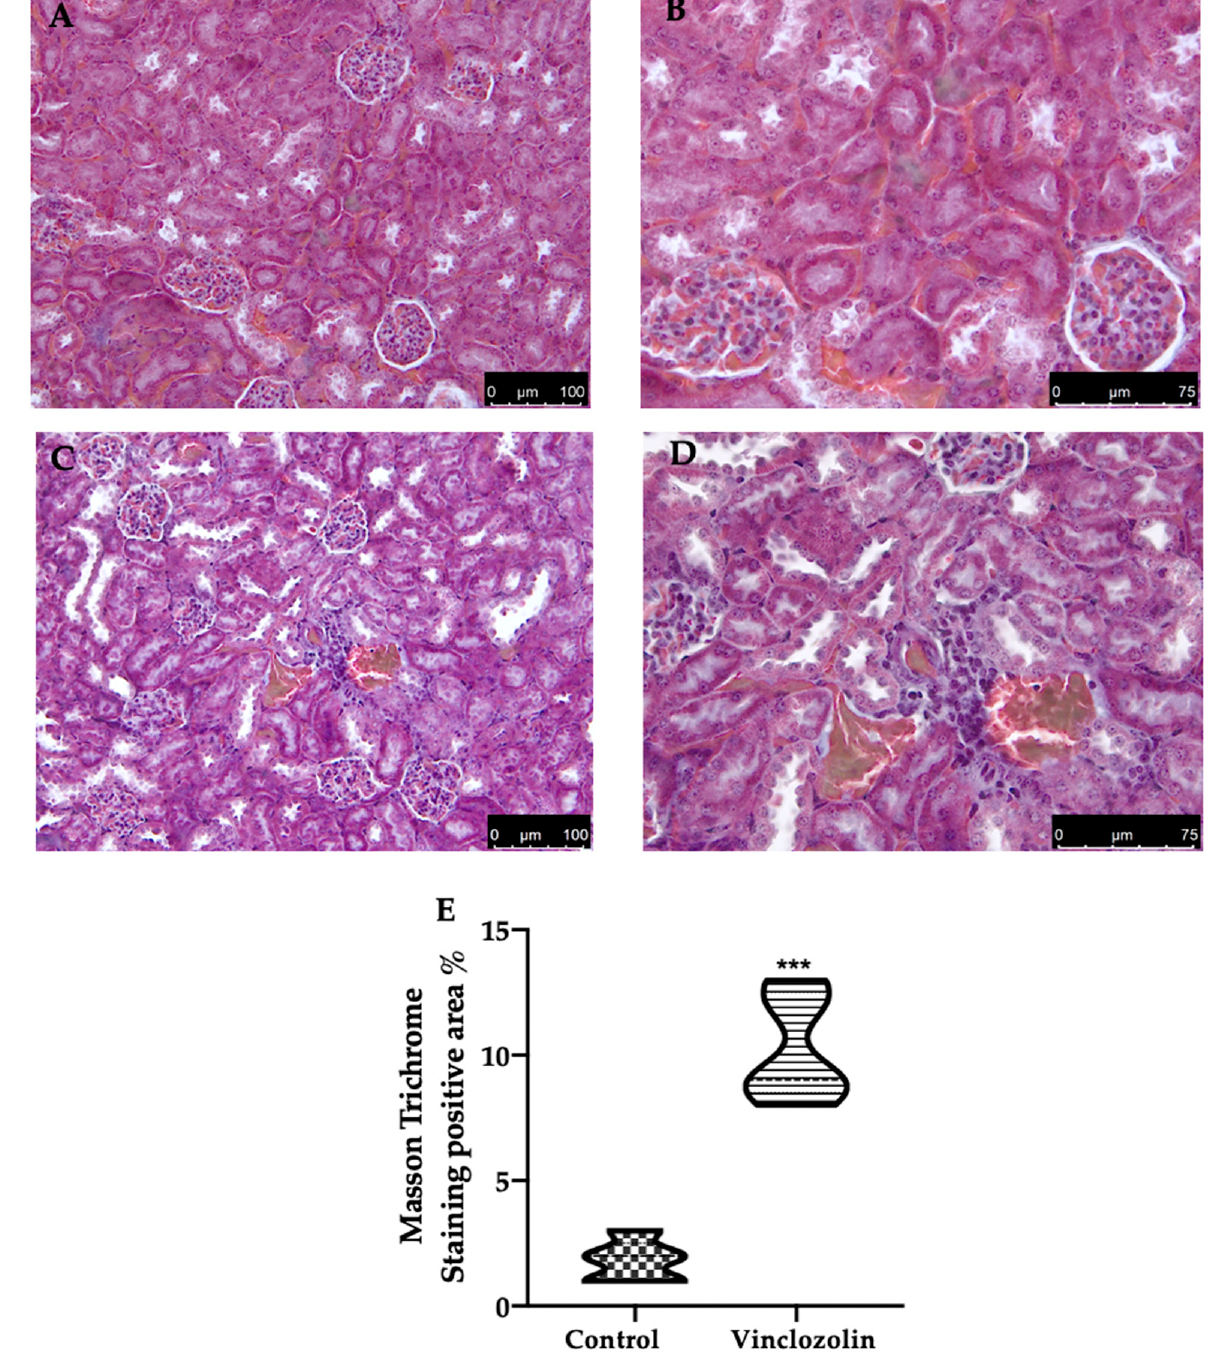
Figure 4. Effects of vinclozolin exposure on kidney fibrosis: Masson Trichrome staining: ( A ) control magnification 20 × ; ( B ) control magnification 40 × ; ( C ) vinclozolin magnification 20 × ; ( D ) vinclozolin magnification 40 × ; ( E ) Masson Trichrome staining positive area %. A p -value less than 0.05 was considered significant. *** p < 0.001 vs. control.